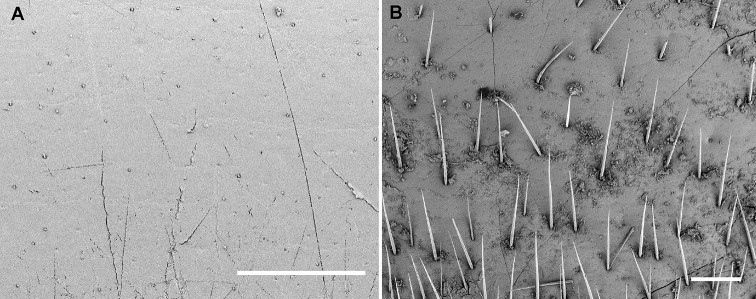
Tergal surface of midbody segments, SEM micrographs. ASphaerobelum
bicorne Attems, 1938, ♂ (ZFMK) BSphaeropoeus
bidoupensis sp. nov., ♂ holotype. Scale bars: 0.2 mm.